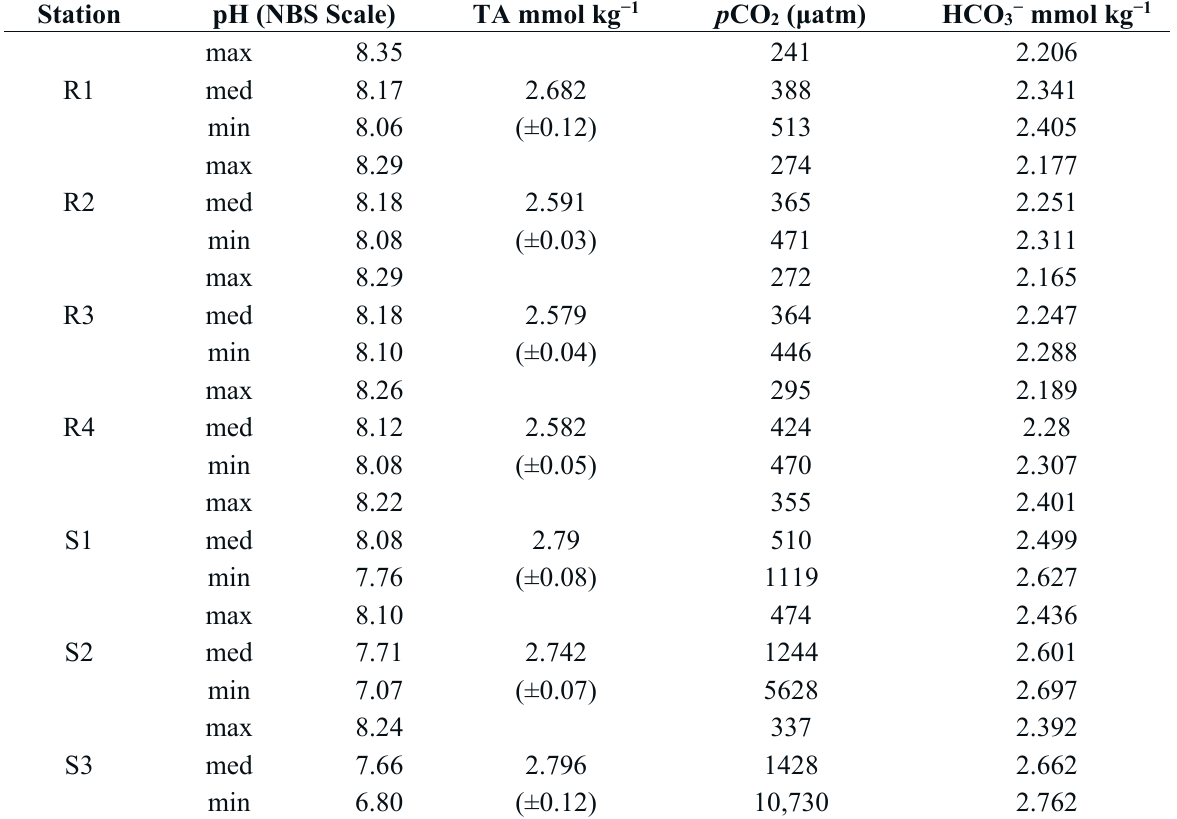
Table 1. Seawater pH, Total Alkalinity (±SE, n = 3) measurements and calculated p CO 2 off Vulcano. Temperature (range 18.6–27.7 °C; April–October), pH (NBS scale) and salinity ( n = 38) were measured on several occasions between September 2009 and September 2011.